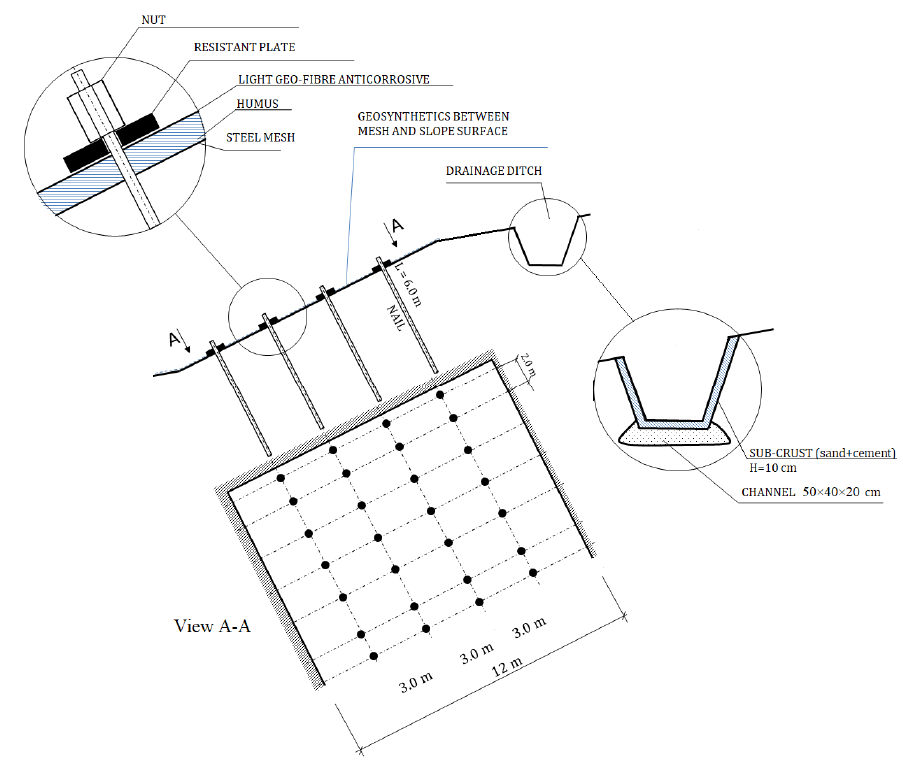
Figure 9. Scheme of slope reinforcement for the Janina mine waste dumps against the impact of high rainfall intensity.